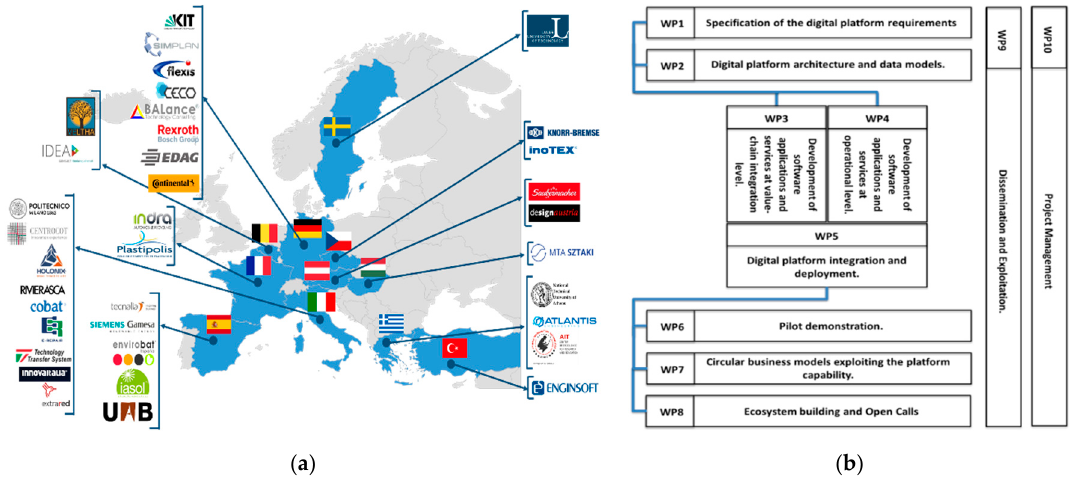
Figure 1. ( a ) DigiPrime Consortium; ( b ) General structure of DigiPrime project highlighting workpackages (WPs)